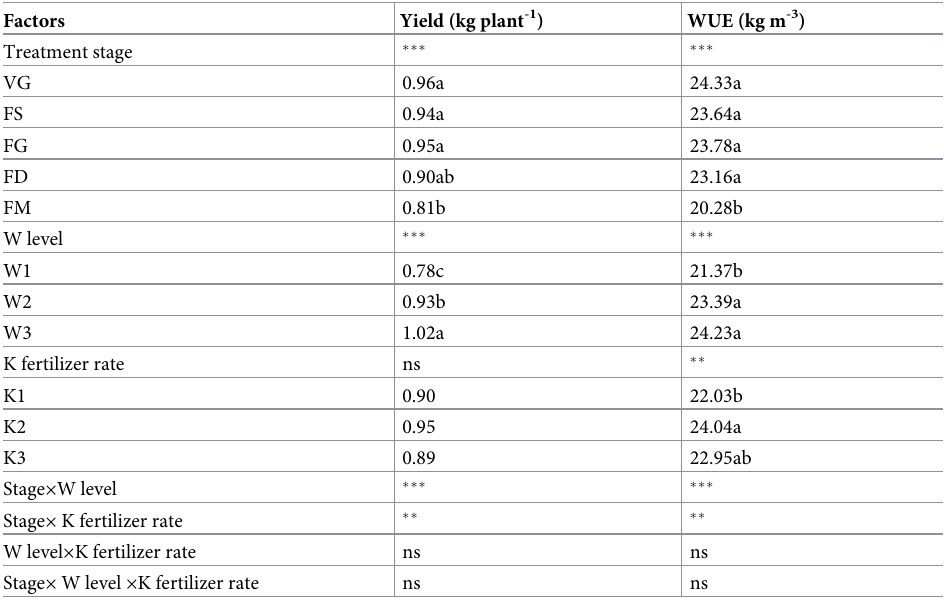
Table 1. Output of three-way analysis of variance (ANOVA) and mean value of tomato yield and WUE as affected by the treatment stage, W level and K fertilizer rate. Factors Yield (kg plant -1 ) WUE (kg m -3 ) Treatment